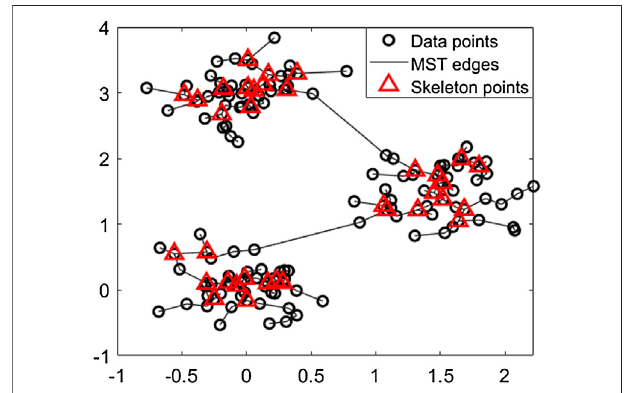
FIGURE 1 | We generate a synthetic dataset, then construct the MST and calculat the skeleton points according to De fi nitions 2.1 – 2.2; they are enclosed by the triangles. As shown, the skeleton points are a type of compressed representation based on the characteristic of the